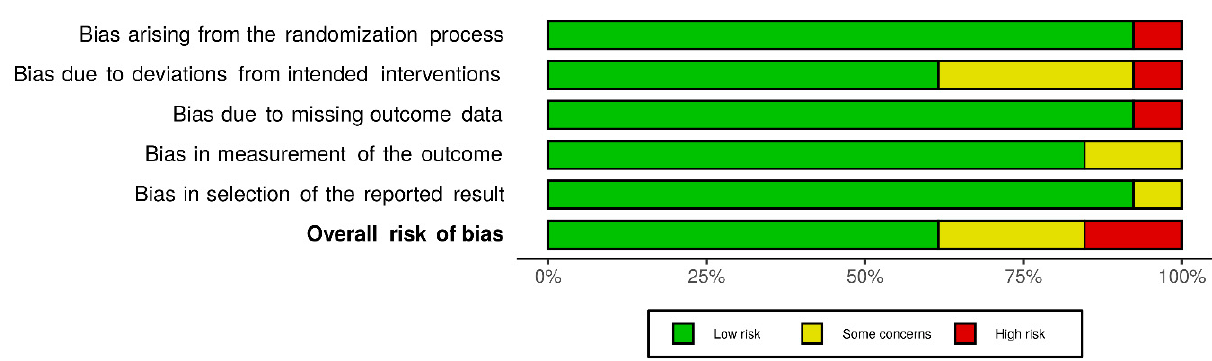
Figure 2. Network graph of the studies related to Ashwagandha supplementation. Node size is proportional to the number of citations, and the color is the publishing year. This graph was developed within www.connectedpapers.com accessed on 23 June 2020.